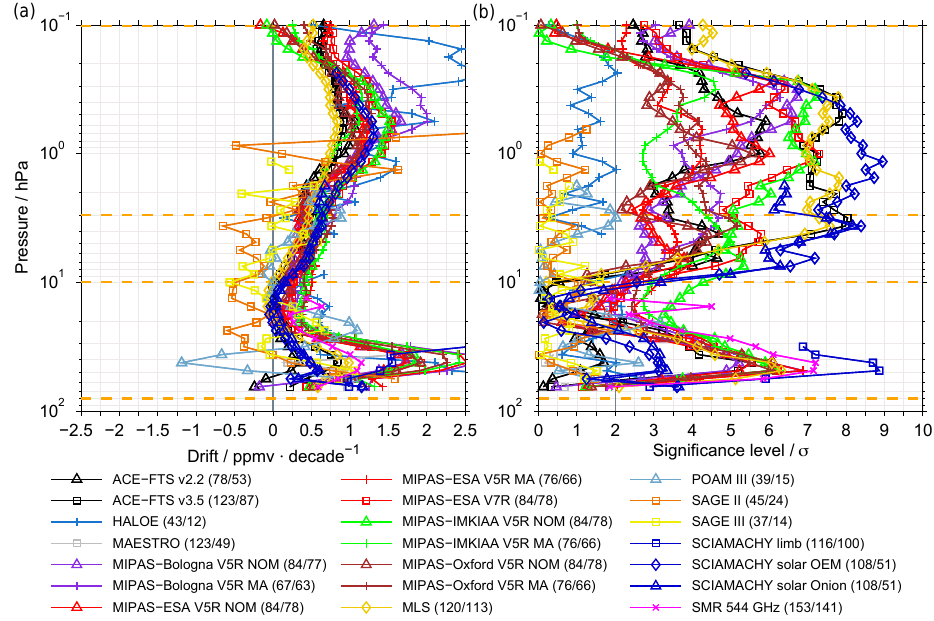
Figure 10. The left panel shows the drifts between the de-seasonalised time series of the SMR 489GHz data set and the other data sets. In the right panel the corresponding significance levels of the drift estimates are shown and the 2 σ level is marked by a vertical line. This example considers the latitude band between 50 ◦ and 60 ◦ N. In the legend, the first number given in parentheses indicates the overlap period (over all altitudes) of the two data sets, i.e. the time between the first and the last month during which the data sets yield a valid monthly mean. Results are only shown here when this time period is at least 36 months. The second number indicates the number of months for which both data sets actually yield a valid monthly